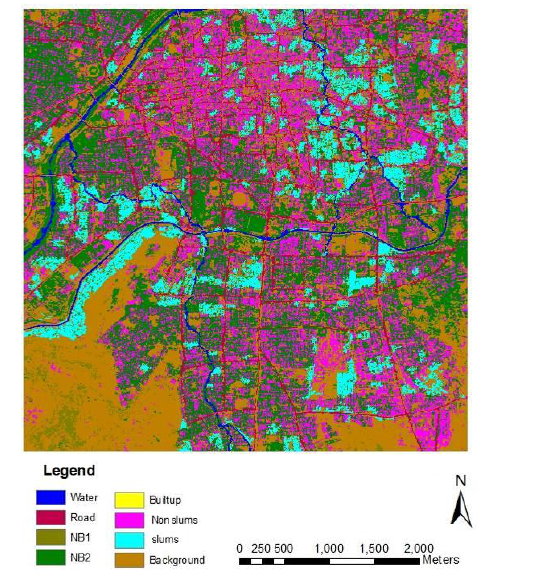
Figure 8. Classified Image of central part of Pune city